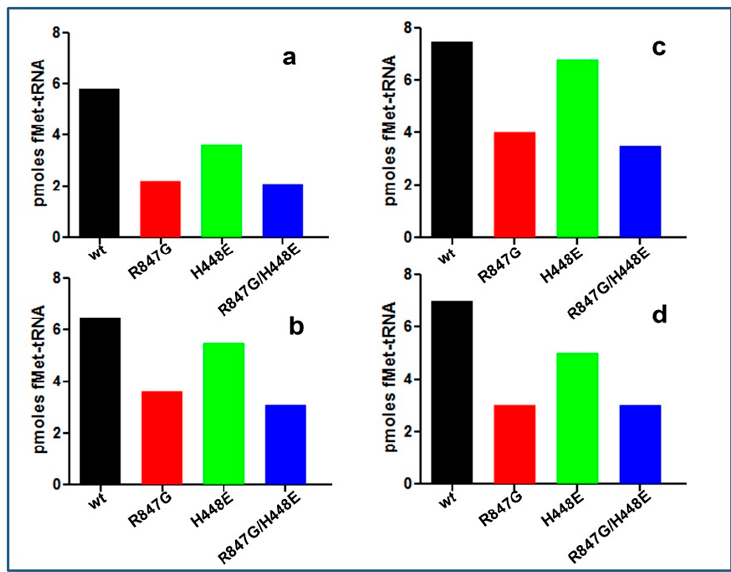
Figure 5. Levels of 30S IC (panels ( a , c )) and 70S IC (panels ( b , d )) formed in the presence of IF2 wt and IF2 mutants. The incubation mixtures contained, in 40 μ L in Buffer D, 1mM GTP, 10 pmol each of 30S subunits or 70S monomers, initiation factors IF1 and IF3, f [ 3 H]Met-tRNA, 022mRNA. In addition, the reaction mixtures contained 10 pmol (panels ( a , b )) or 60 pmol (panels c and d) of pu- rified IF2 wt (black), IF2 R847G (red), IF2 H448E/R847G (blue), and IF2 H448E (green). After 15 min incubation at 37 °C, the amounts of fMet-tRNA bound in the 30S ( a , c ) or 70S ( b , d )) initiation com- plexes were determined by Millipore filtration. The levels of fMet-tRNA bound to ribosome in the absence of IF2 have been subtracted.